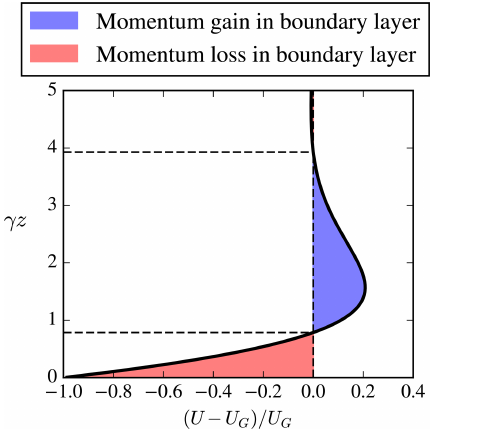
Figure B1. Stress divergence in an Ekman